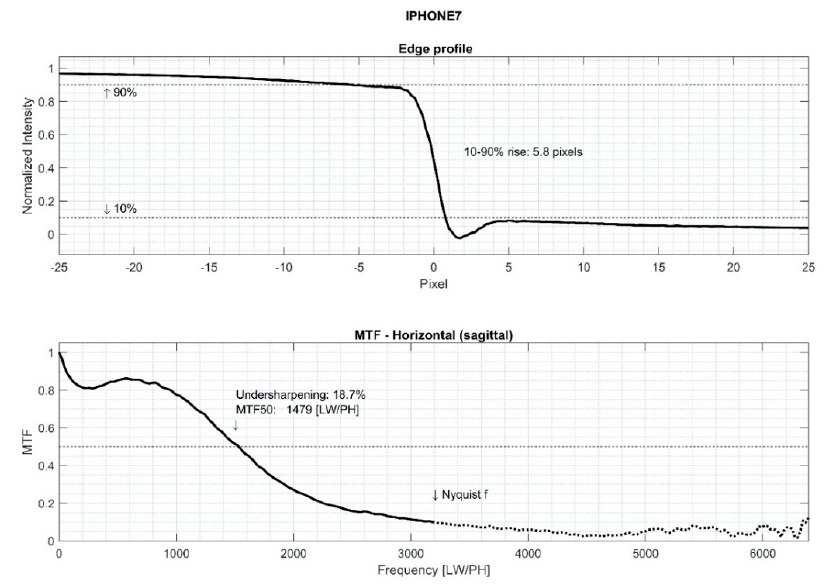
Figure 6. Sharpness results for iPhone 7 camera with DermLite 4 DL dermoscope.